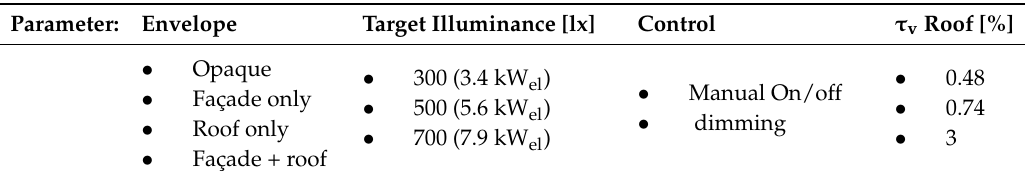
Figure 4. ( a ) 3D model in SketchUp, view from north; and ( b ) group definition of lighting sections. Table 5. Overview of the values of the varied scenario parameters for Light Groups 2–4. Not all of the possible combinations were